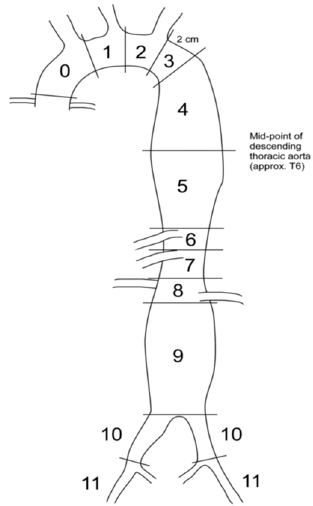
Figure 1. Zones of aortic injury [12].